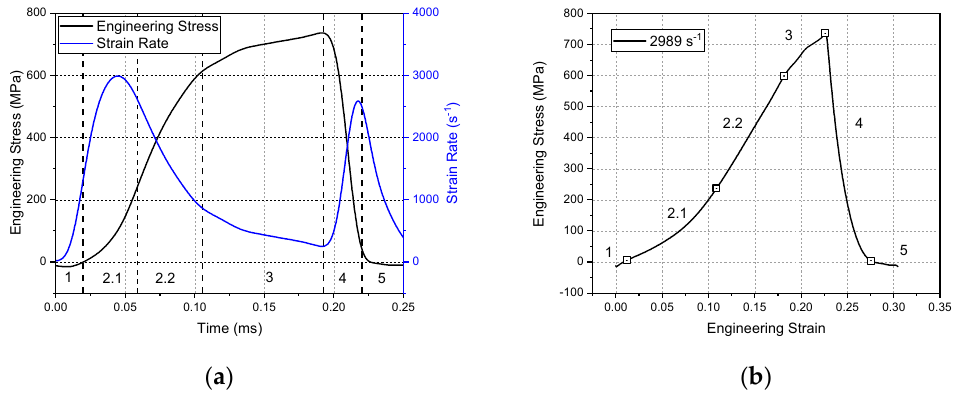
Figure 8. Evolution of the stress and strain rate curves of damaging test under out-of-plane loading: ( a ) stress and strain rate vs. time curves; ( b ) stress vs. strain curve. Zone 1 and Zone 2 were the same as those for the non-damaged (b) Damage Kinetics